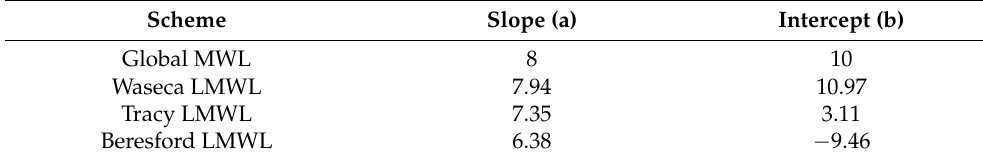
Table 3. Parameters of meteoric water